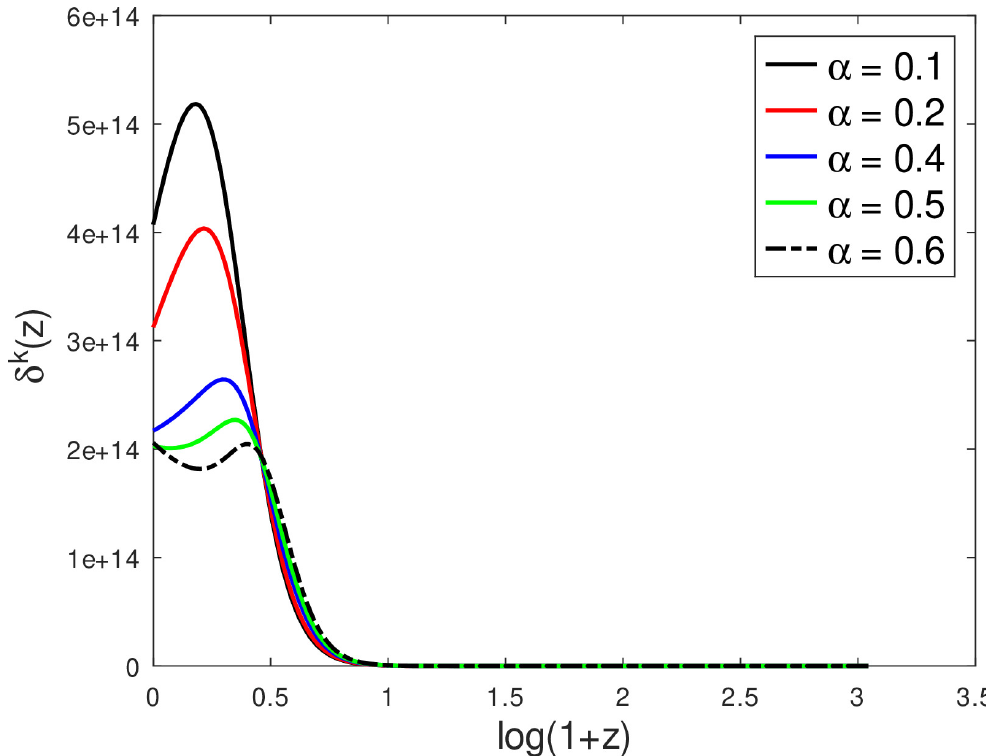
Figure 8. The variation of the matter density perturbations δ k ( z ) for a viscous Bianchi type-V cosmological model vs. redshift for γ = 50, β = 1, n = 0.2, and different values of α .